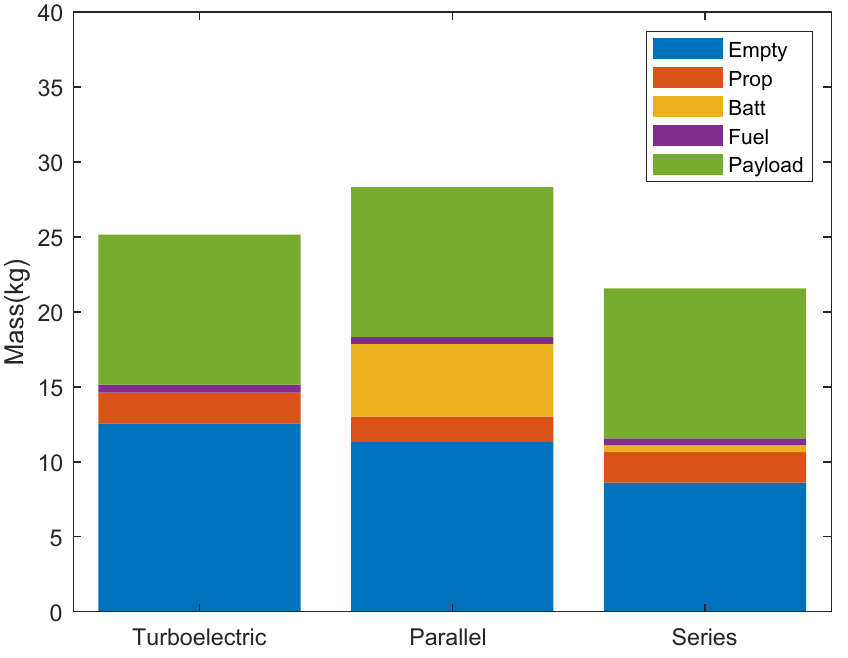
Figure 6. Case 2: MTOM and mass of other parts of UAVs.